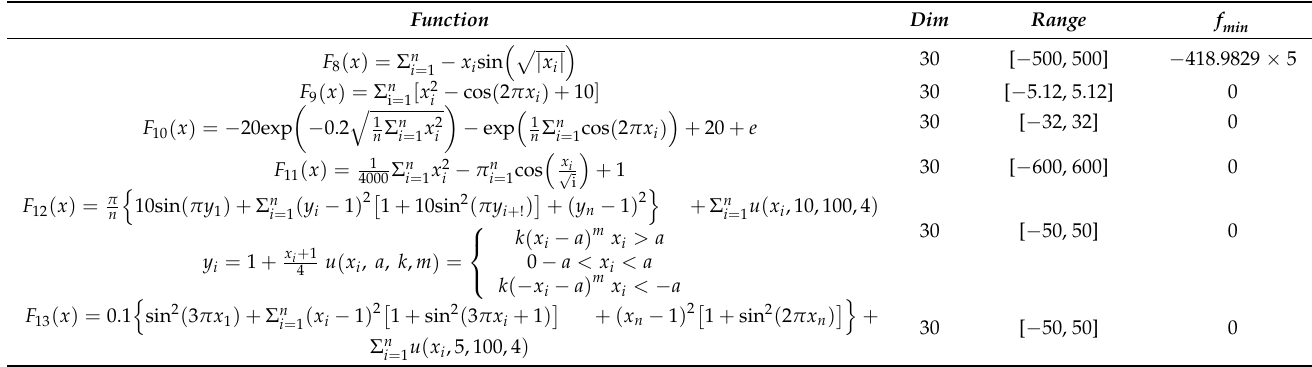
Table 2. Description of multimodal benchmark functions ( F 8 – F 13